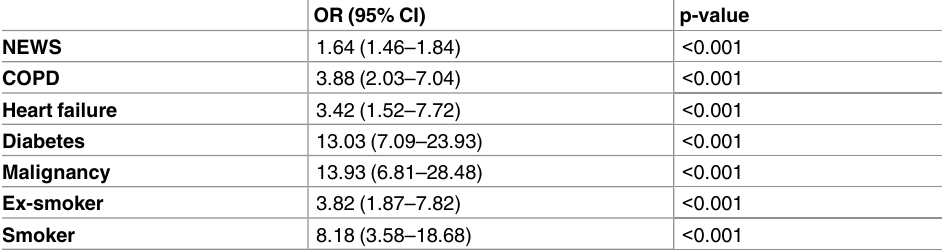
Data presented as adjusted odds ratios presented with 95% confidence intervals.